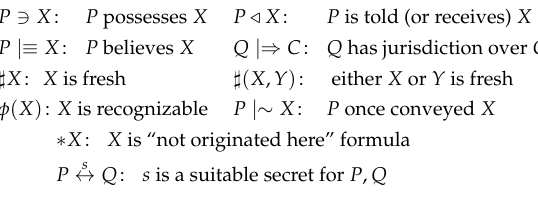
Figure A1. GNY reasoning notation.